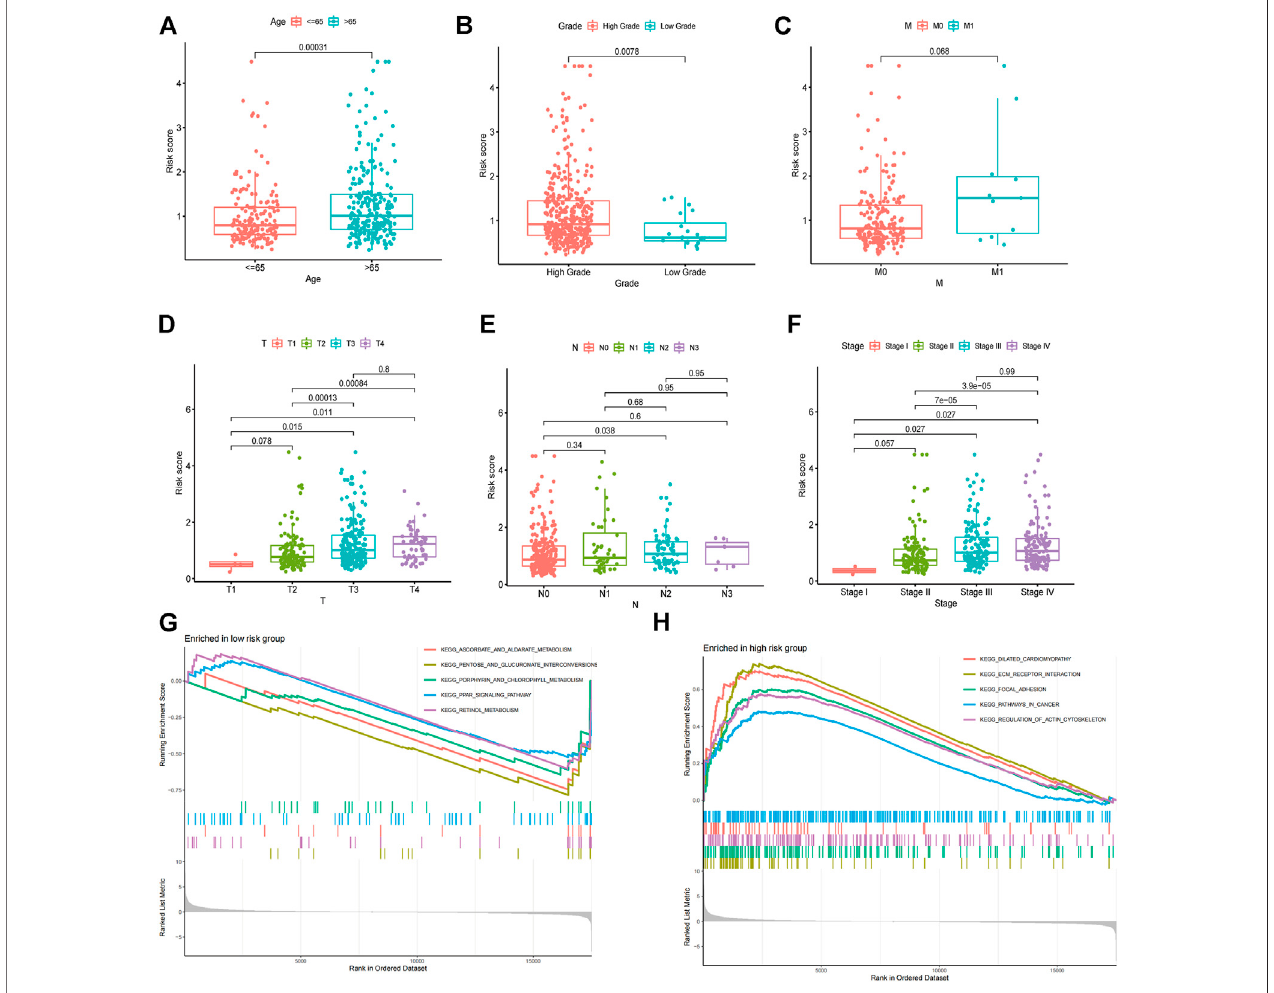
FIGURE6| Associationbetweentheriskmodelwithclinicalcharacteristics.Correlationanalysisofriskscorewithage (A) ,grade (B) ,Mstage (C) ,Tstage (D) , N stage (E) , and clinical stage (F) . GSEA enrichment analysis of biological activities between the low (G) and high (H) risk groups.